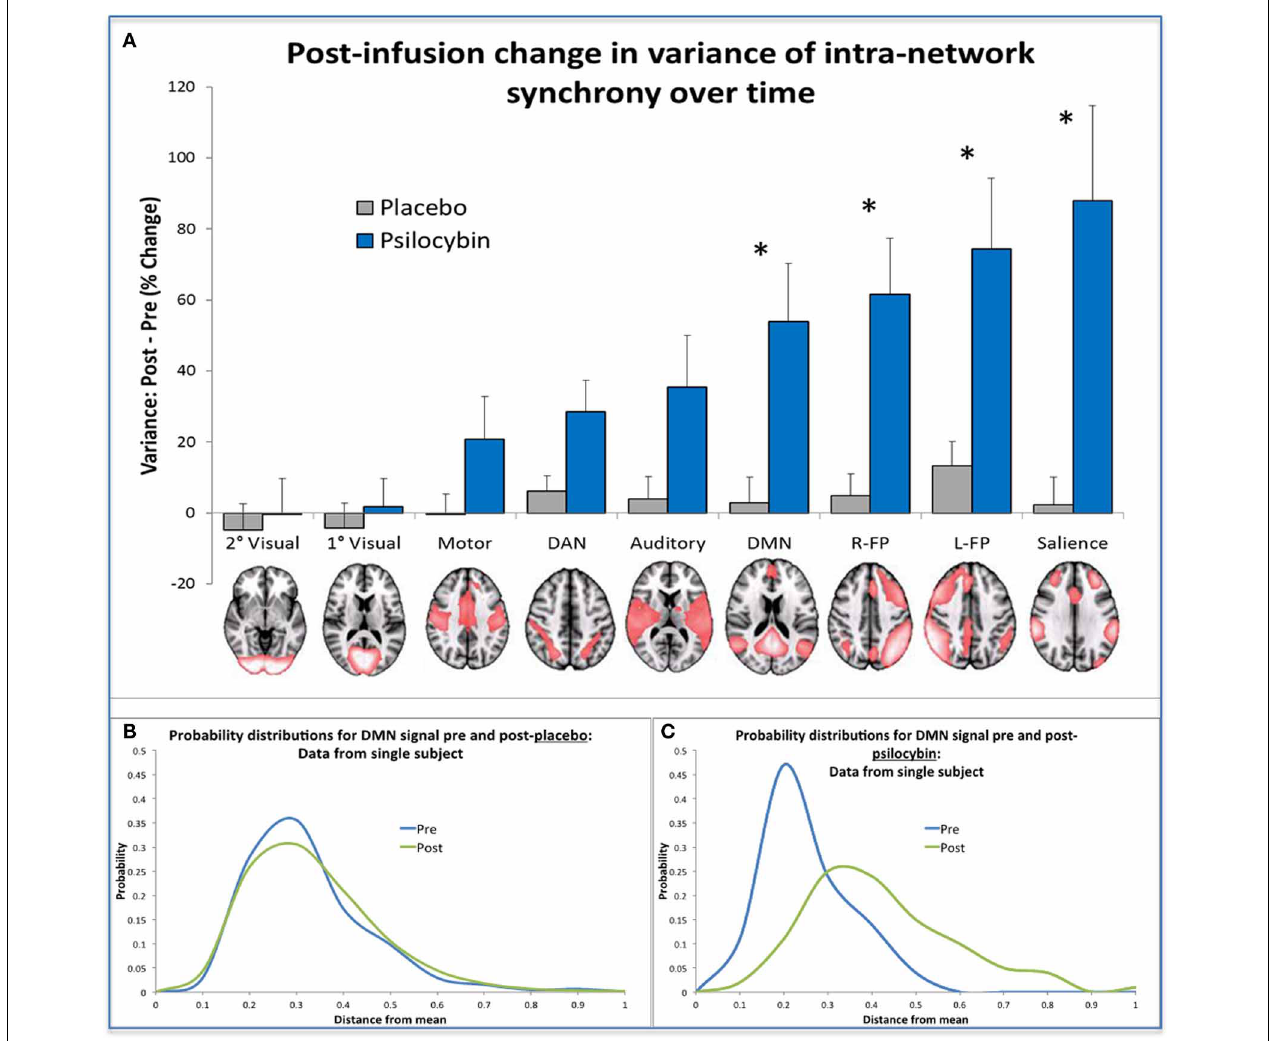
FIGURE 6 | Changes in network metastability and entropy post-infusion of psilocybin. (A) This chart displays the mean variance of the internal synchrony of 9 brain networks for the sample of 15 healthy volunteers, as a percentage change post vs. pre-infusion. A post-infusion increase in metastability for a specific network indicates that the mean signal in that network is a poor model of the activity in its constituent voxels, implying that the network is behaving more “chaotically” post-infusion than pre. Bonferonni correction gave a revised statistical threshold of p < 0 . 006 (0.05/9). One-sample (2-tailed) t -tests were performed, comparing the % change against zero. The significant networks are labeled with an asterisk. (B,C) These probability distributions were derived from data from the same single subject, by discretizing a measure of the internal synchrony of the DMN across time into bins. These bins